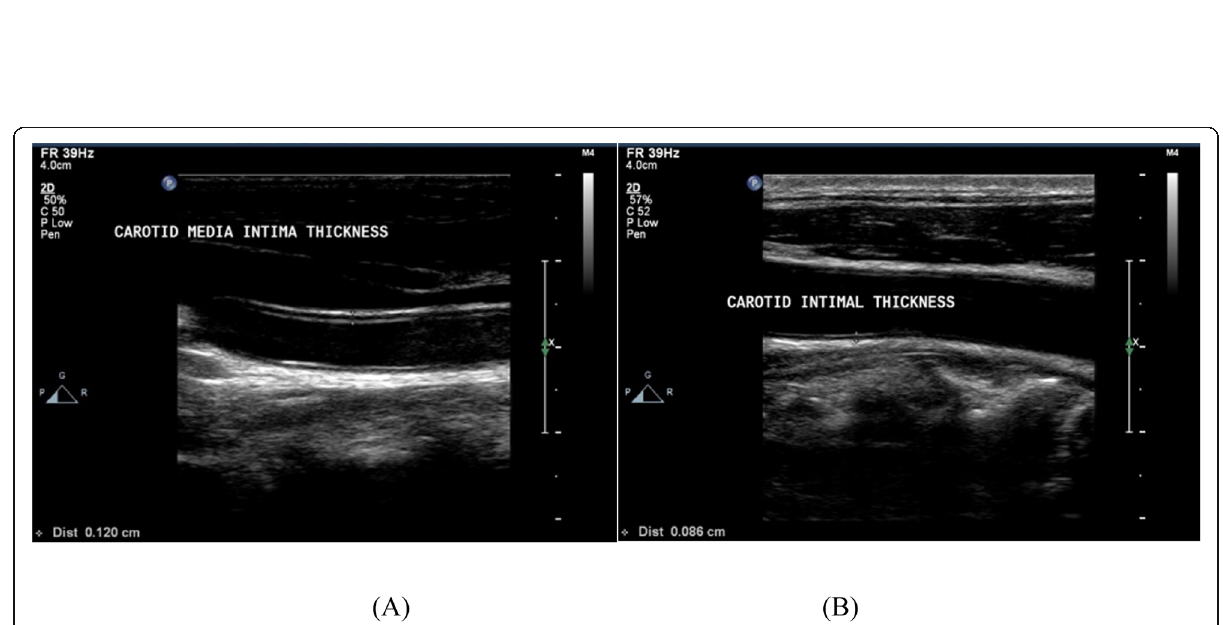
Fig. 2 C-IMT measurement. Patient ( a ) had a normal C-IMT (0.12 mm). Patient ( b ) had an increased C-IMT (0.86 mm). C-IMT: Carotid intima-media